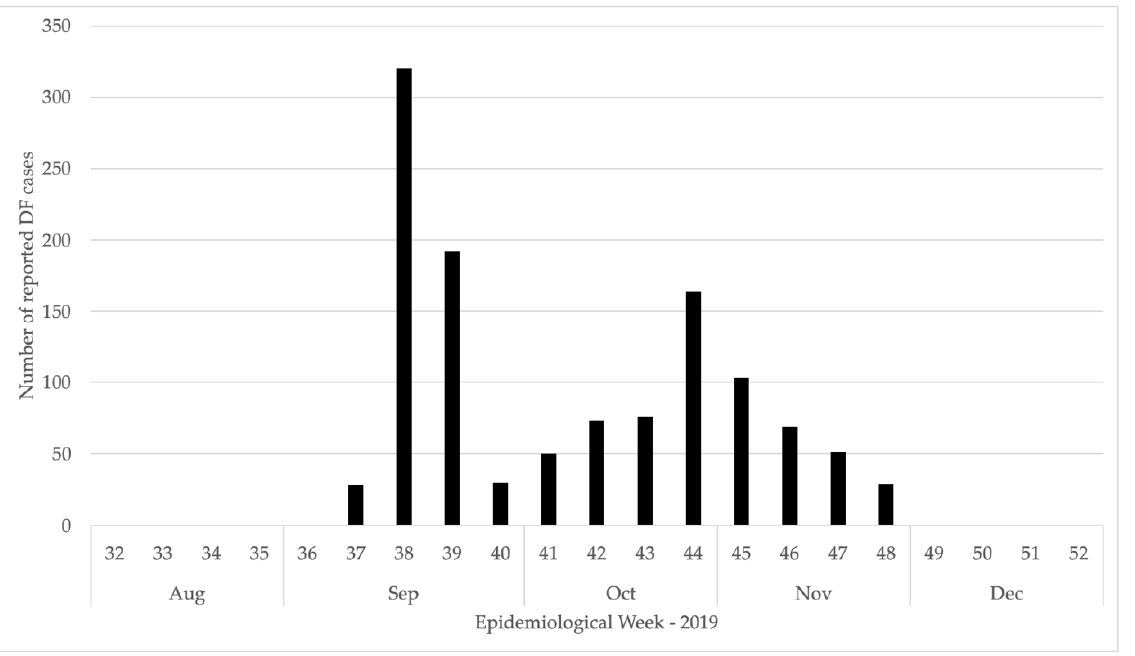
Figure 3. Distribution of reported DF cases by their date of onset, from September to November 2019 in Gewane District, Afar Region, Ethiopia ( n = 1185).